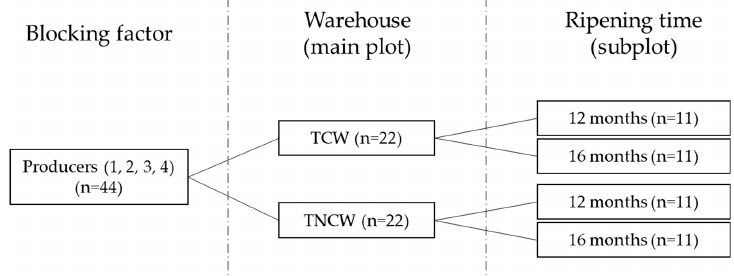
Figure 1. Experimental design schematization. TCW = temperature conditioned warehouse; TNCW = traditional non conditioned warehouse; n = number of cheeses.